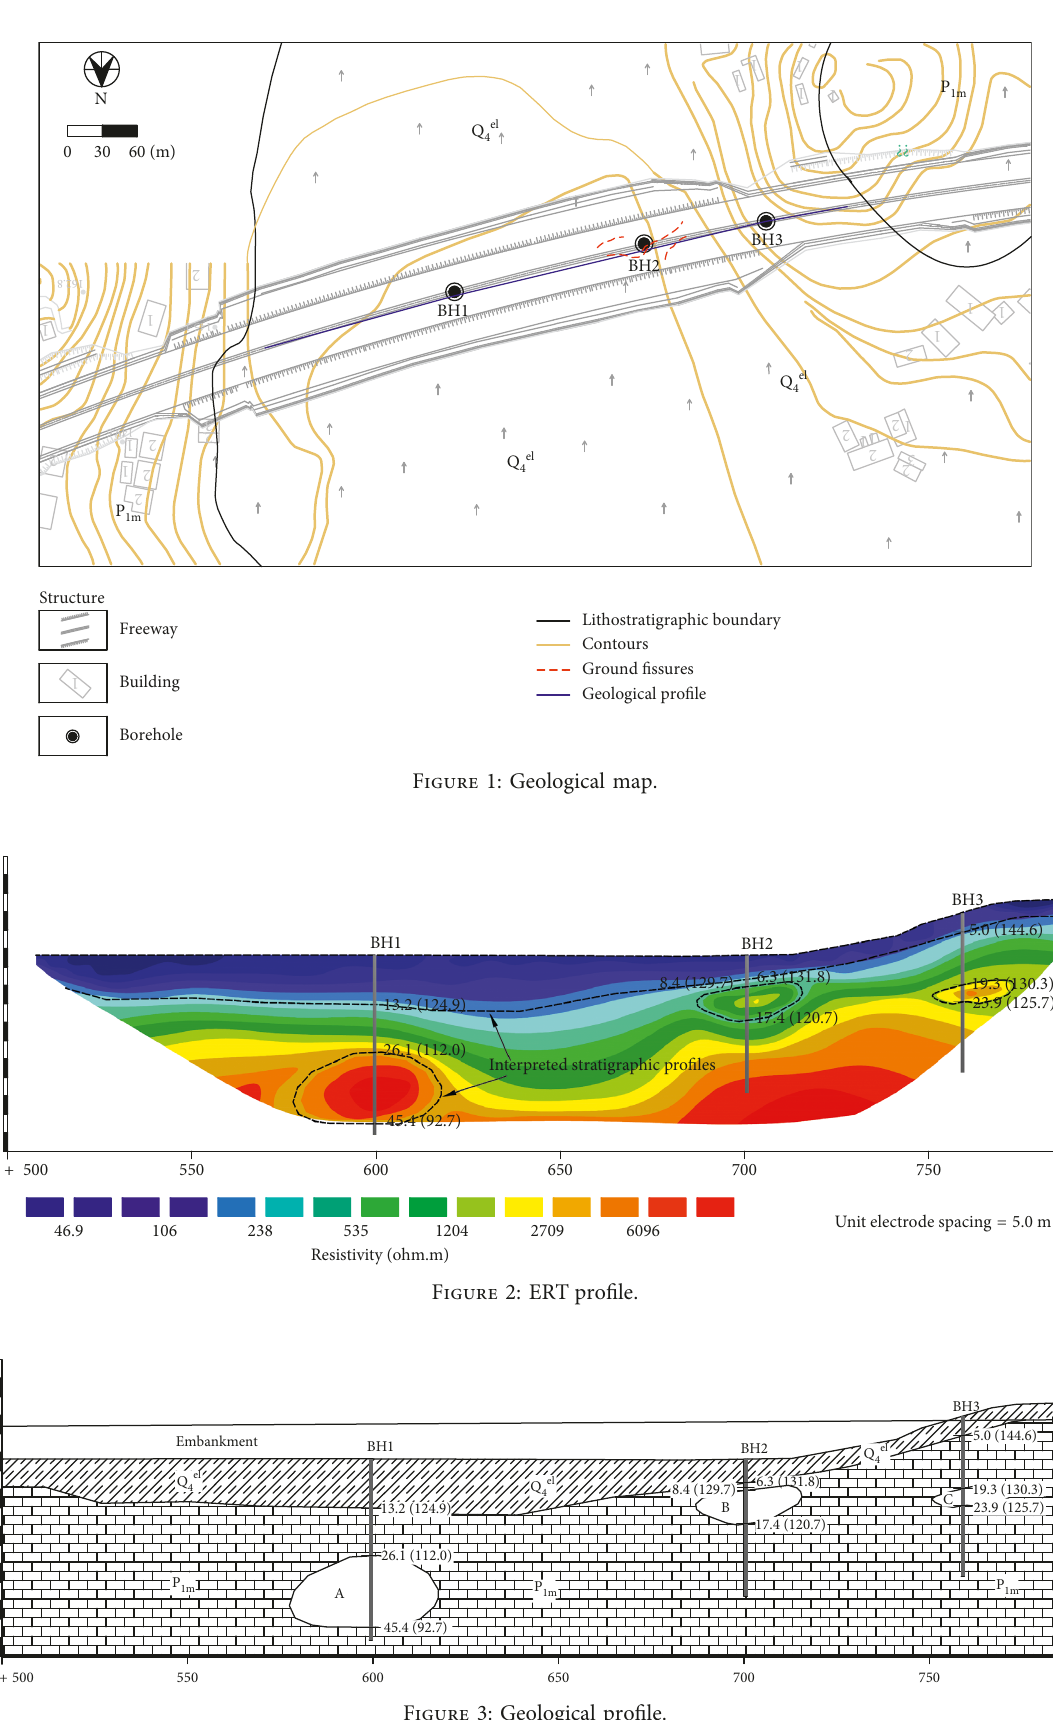
Figure 3: Geological